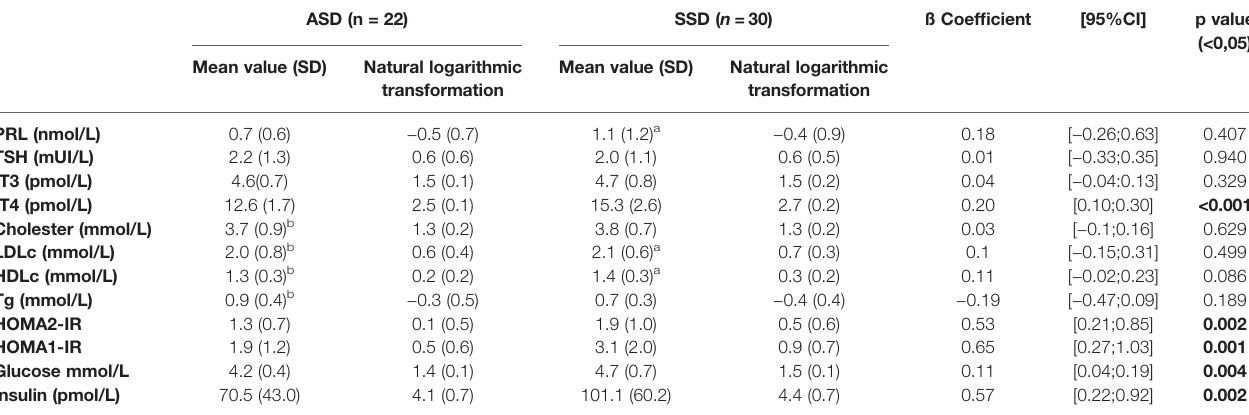
a Missing values for one participant, b Missing values for two participants. ASD, affective spectrum disorder; fT3, free triiodothyronine; fT4, free thyroxin; HDLc, high-density lipoprotein cholesterol; LDLc, low-density lipoprotein cholesterol; PRL, prolactin; SSD, schizophrenia spectrum disorder; Tg, triglycerides; TSH, thyroid stimulating